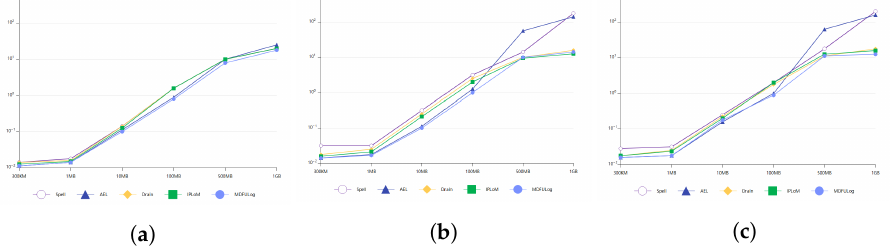
Figure 8. Efficiency of log parsing methods on various log volumes. ( a ) HDFS. ( b ) BGL. ( c )